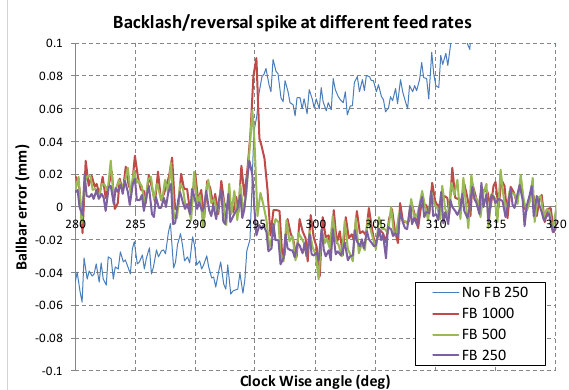
Figure 31. Comparison of ballbar test backlash/reversal spike occurring at around 295° clockwise (65° CCW in Figure 17) for different robot speeds.